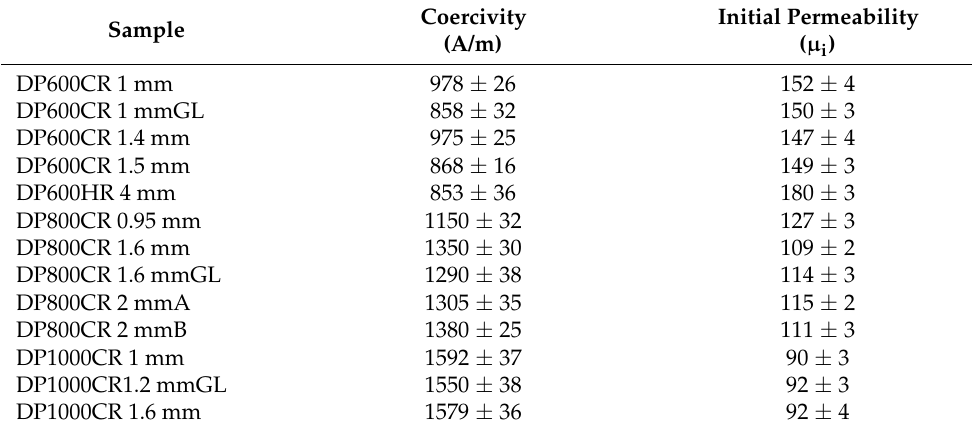
Figure 3. Major hysteresis loops and initial magnetisation curves for the commercial DP600, DP800 and DP1000 steel samples. Table 2. Measured coercivity and initial permeability values for the commercial DP600, DP800 and DP1000 steel samples.